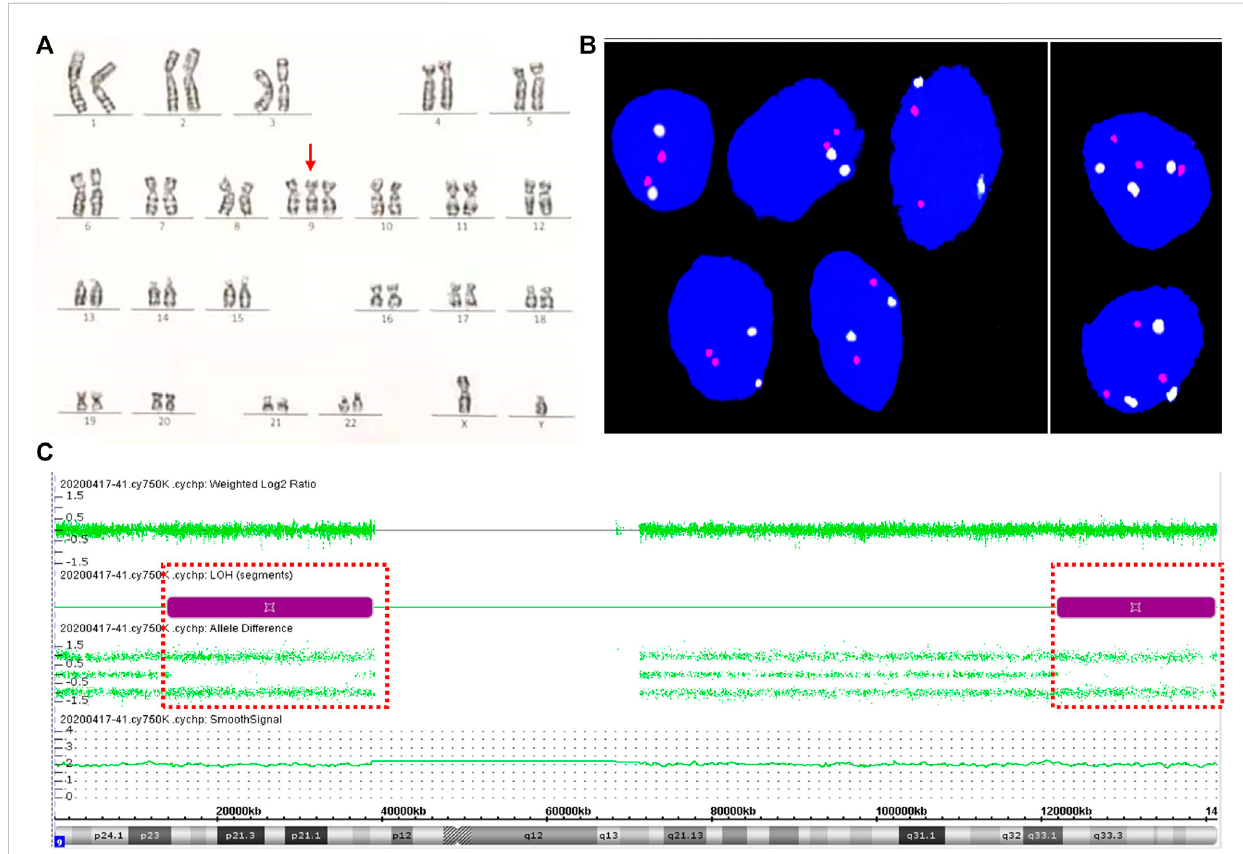
FIGURE 2 Results for trisomy 9 mosaicism in Case 2. (A) Karyotype pro fi les indicating trisomy 9 (red arrows indicated the chromosome 9). (B) FISH pro fi les of 8.2% trisomy 9 mosaicism in interphase uncultured oral mucosal cells using chromosome 9 centromere-speci fi c (white) and 9qter telomeres-speci fi c probe (red). (C) CMA assay results of uncultured amniocytes for Case 2. LOH at 9p23p13.1 and 9q33.1q34.3 detected by CMA (positions of LOH are indicated by the dashed